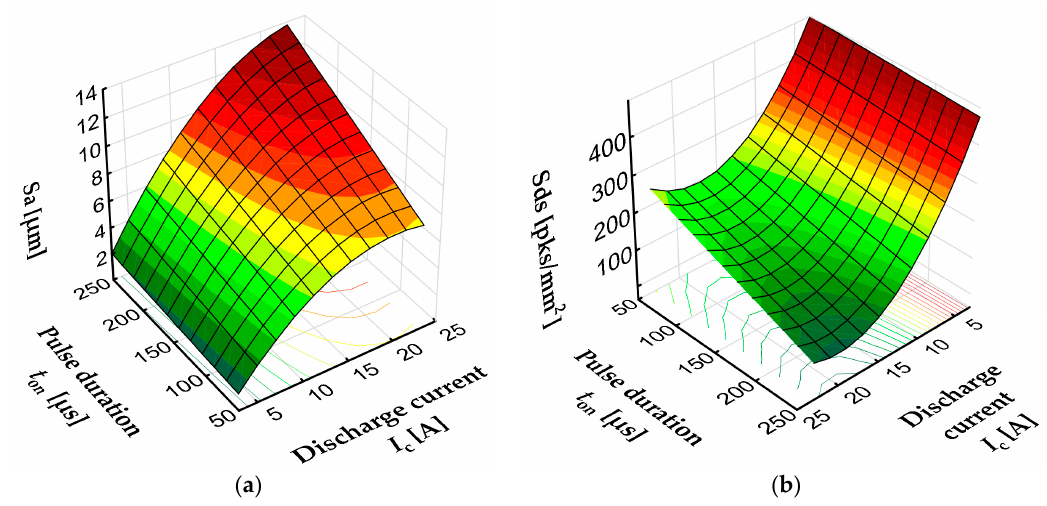
Figure 7. Estimated response surface for ( a ) the arithmetic mean of the deviations from the mean Sa and ( b ) the density of the top Sds.